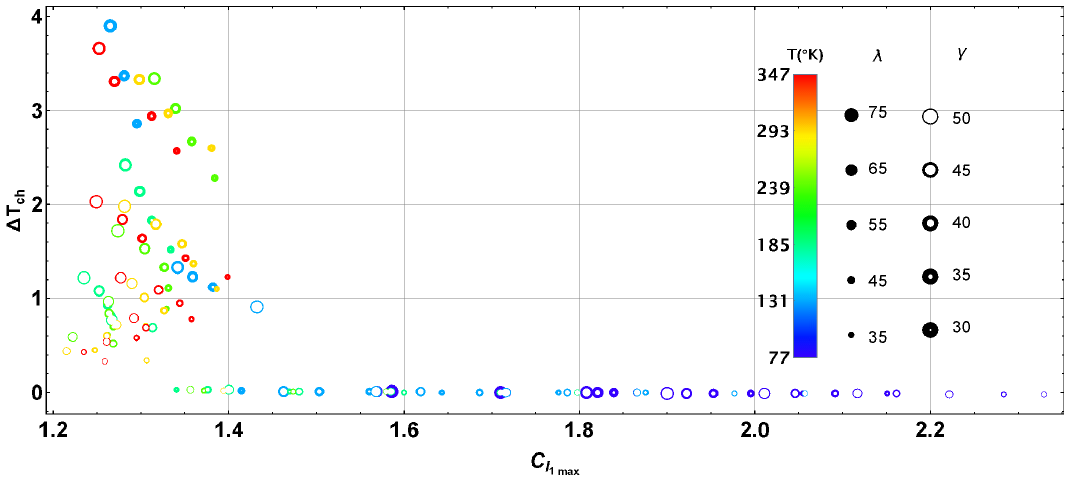
Figure 9. ( A ) Maximum coherence C l as function of T , λ k and γ k .